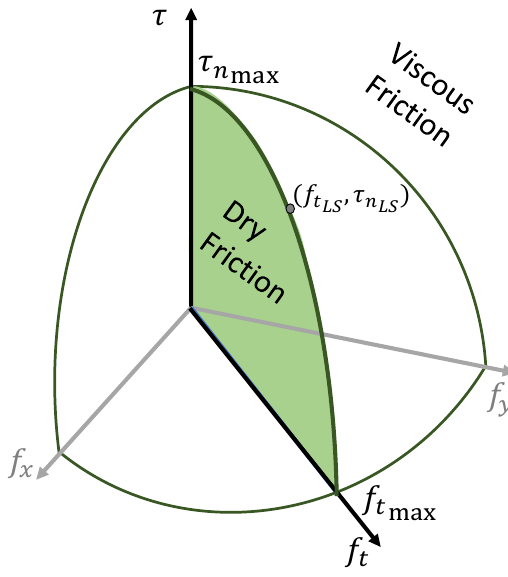
Figure 2. Limit surface represented in the 3-D space.